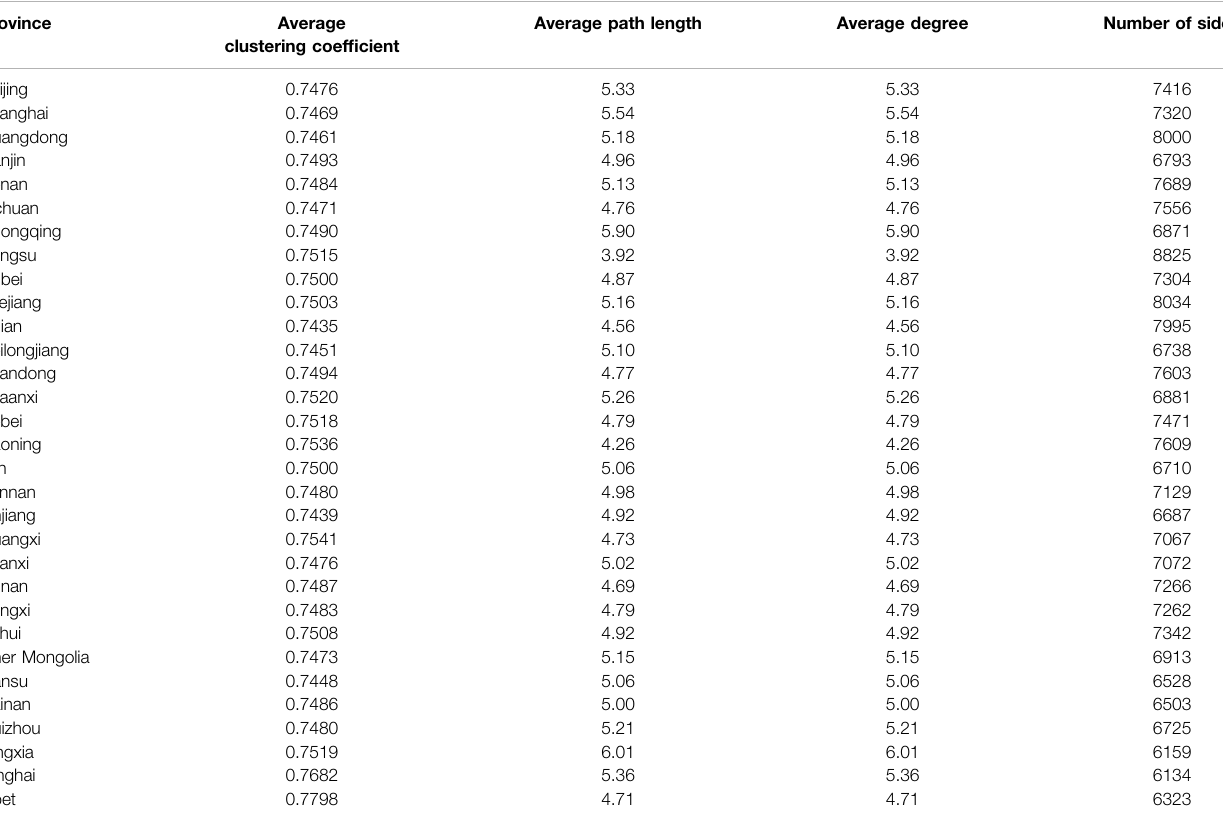
TABLE 2 | Visibility network parameters.